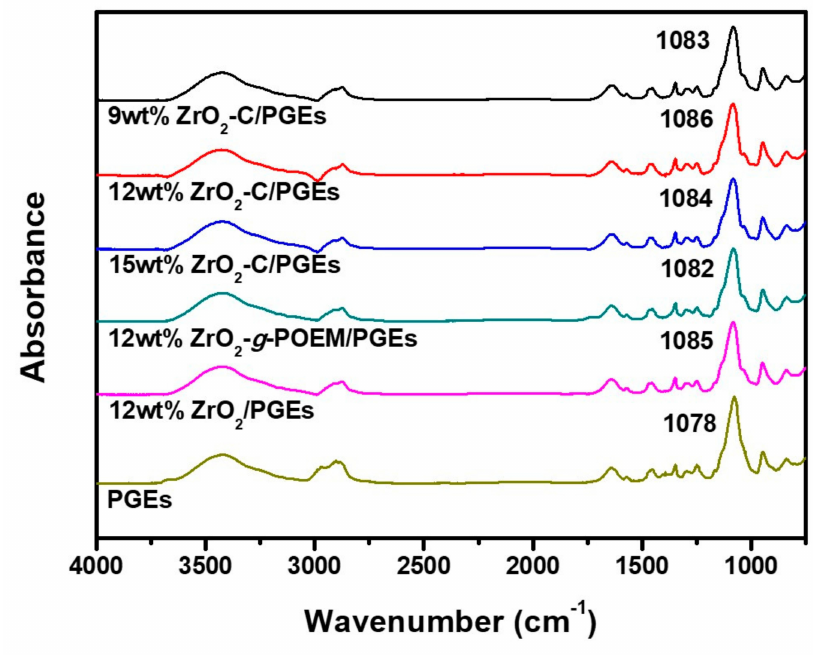
Figure 3. FT-IR spectra of PGEs, 12 wt% ZrO 2 / PGEs, 12 wt% ZrO 2 - g -POEM / PGEs, 15 wt% ZrO 2 -C / PGEs, 12 wt% ZrO 2 -C / PGEs, and 9 wt% ZrO 2 -C /